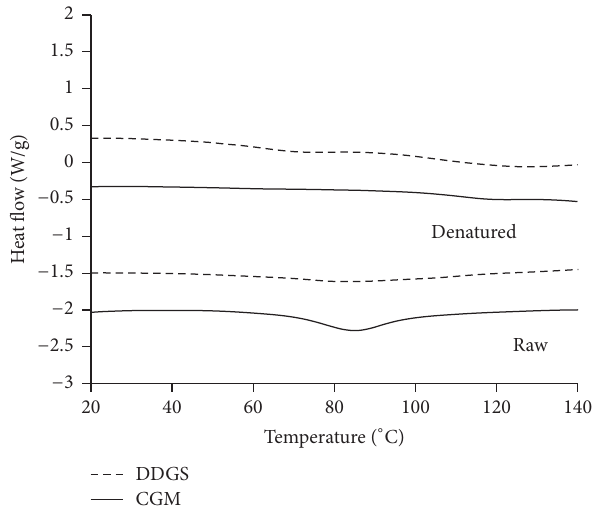
Figure 3: DSC thermograms of CGM and DDGS before and after